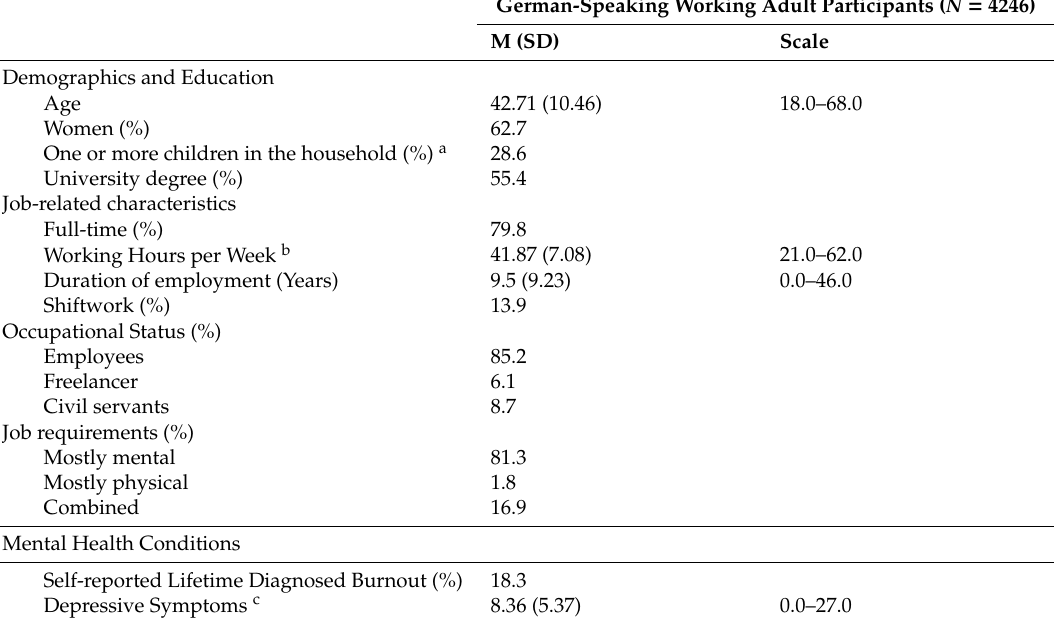
Table 1. Description of the